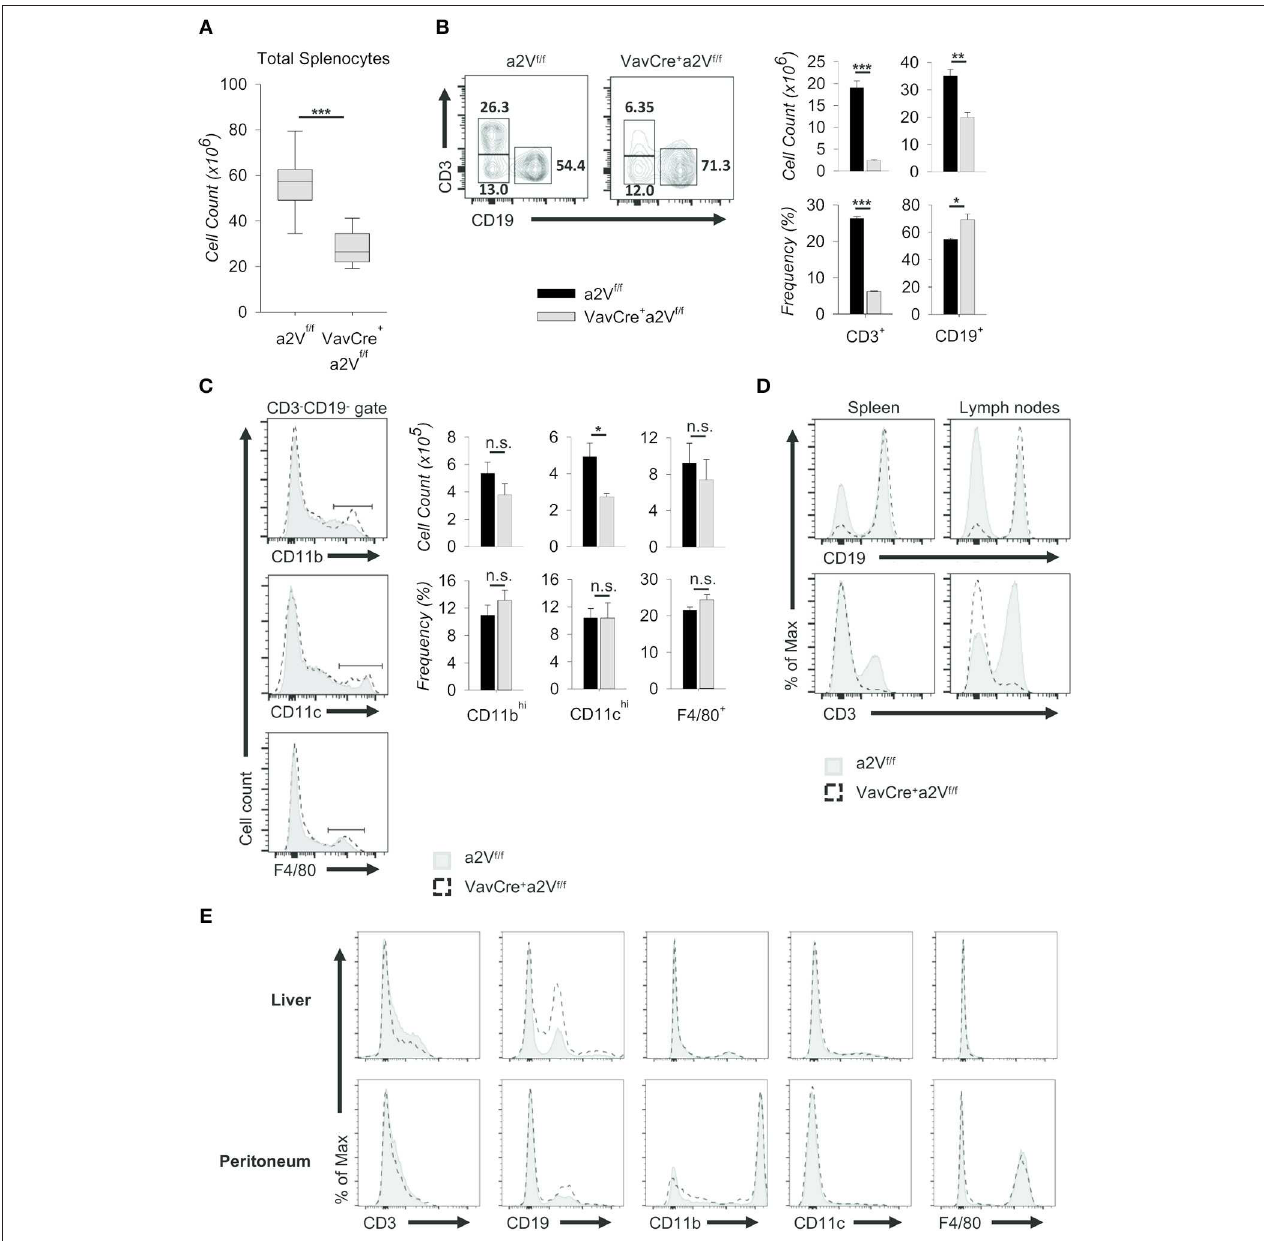
FIGURE 3 | Characterization of peripheral lymphopenia in Vav Cre a2V fl / fl mice. Cells from spleens, lymph nodes, livers, and peritoneal cavities of a2V fl / fl and Vav Cre a2V fl / fl mice were isolated, counted by Trypan blue exclusion on a hemocytometer or by size exclusion on a BD Accuri C6, and analyzed by flow cytometry (A–E) . (A) Absolute number of cells isolated from a2V fl / fl and Vav Cre a2V fl / fl spleens ( n = 9 each group). Data are pooled from three independent experiments and representative of seven total experiments. (B) Representative flow plots and quantification by frequency and absolute number of T (CD3 + ) and B (CD19 + ) cells. (C) Representative flow plots and quantification by frequency and absolute number of major myeloid populations within the CD3 − CD19 − gate. (D) Flow cytometric analysis of T and B cell population shifts in a2V fl / fl and Vav Cre a2V fl / fl spleens and lymph nodes. (E) Frequencies of major cell subsets in non-lymphoid tissues of liver and peritoneum. Numbers in flow plots represent the frequency of each gate. Numeric data represents means ± SEM. Data in histograms are normalized to the mode. Unless otherwise noted, all data are representative of at least three independent experiments with n ≥ 3. n.s., no significance, * p ≤ 0.05, ** p ≤ 0.01, *** p ≤ 0.001.